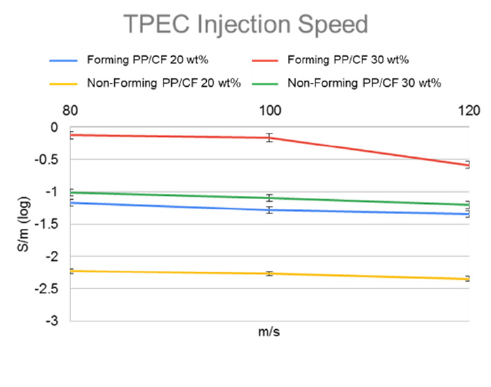
Figure 5. ( a ) TPEC and ( b ) tensile strength of samples with different CF contents at different injection speeds (for comparison, TPEC are presented in log scale). Comparisons for MuCell-molded (foaming) parts and CIM-molded parts (non-foaming). High mold temperatures resulted in thinner skin layers and less shear stress in the core region (i.e., less orientation along the flow direction); thus, the TPEC slightly in- creased. A similar result was obtained at high melt temperatures. High melt temperatures resulted in low melt viscosity and shear stress reduction, and the TPEC decreased. Due to the limitation of the article length, the variation in FOL with various processing parame- ters and the effects of the melt and mold temperatures are summarized in Table 3. Table 3. FOL, TEPC, and TS for the experiments.